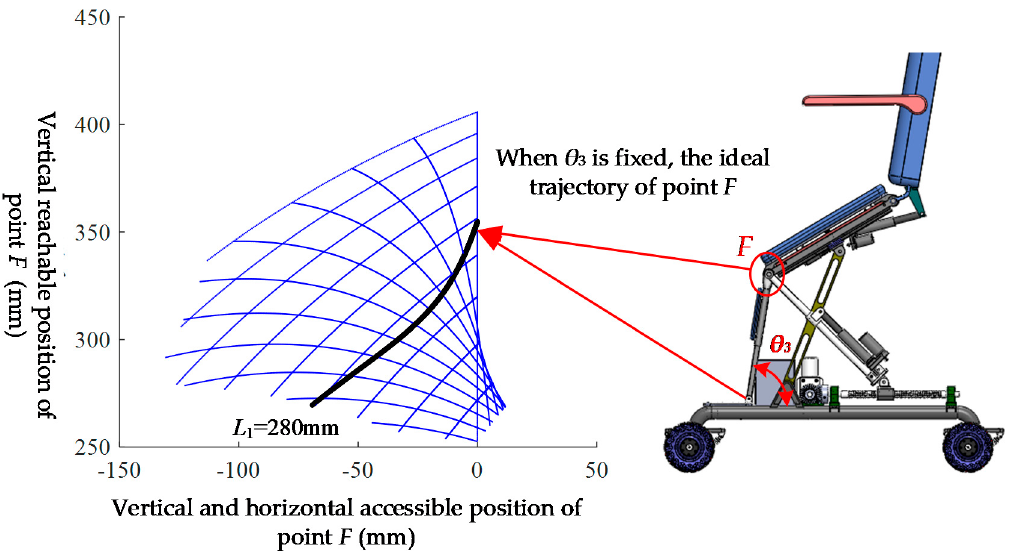
Figure 13. Ideal trajectory of point F.